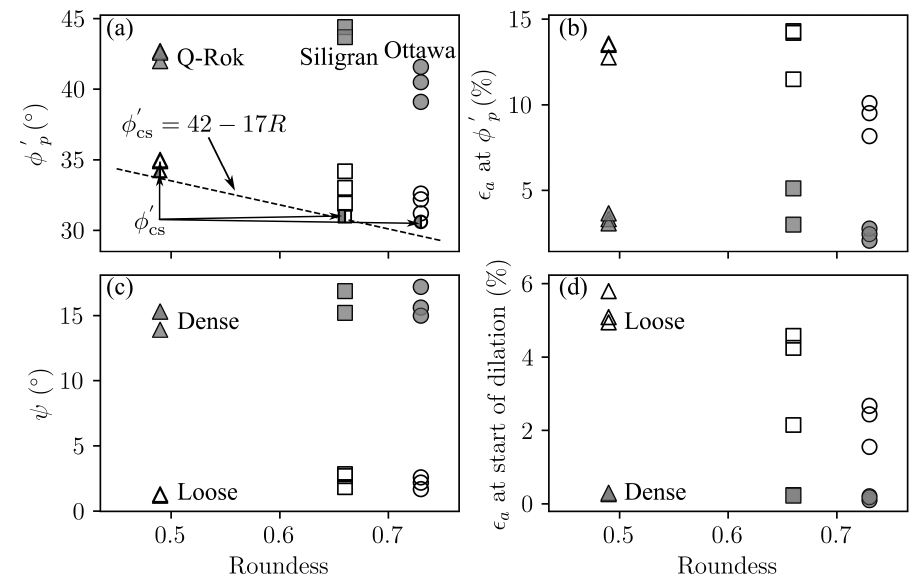
Figure 16. Effect of D r on strength and volume parameters in conventional drained triaxial testing: ( a ) peak friction angle, ( b ) axial strain at peak friction angle, ( c ) dilation angle, ( d ) axial strain at the start of dilation.